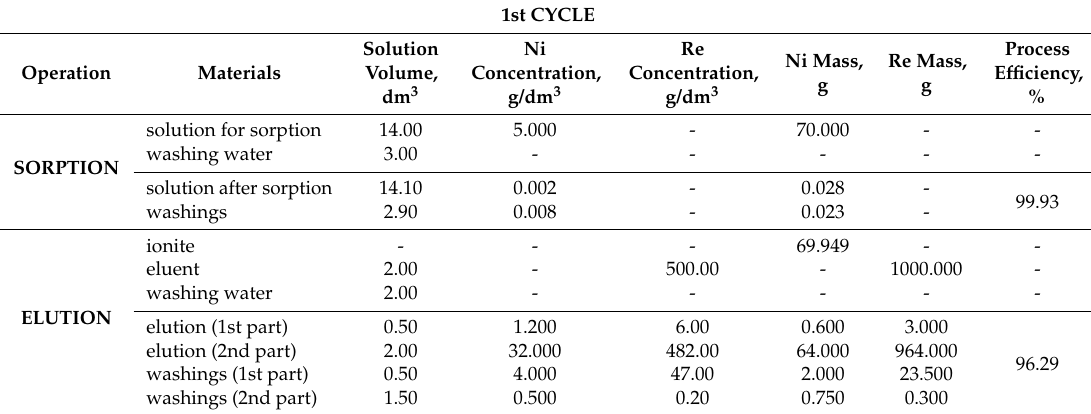
Table 15. Balance for nickel(II) sorption and elution—1st cycle.